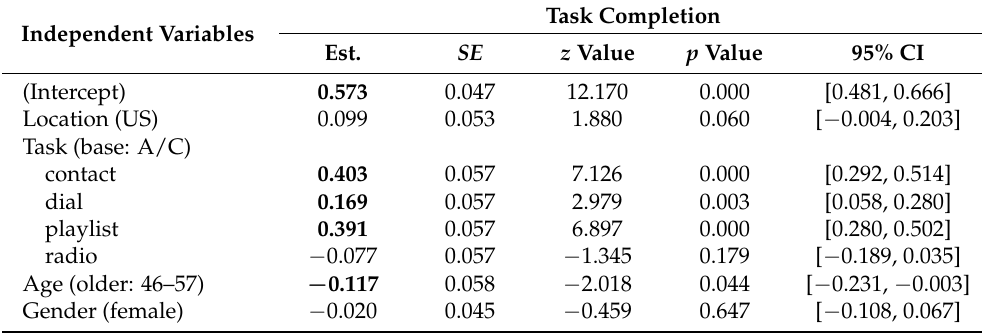
Table 3. Estimated coefficients for task completion (objective workload measure) 1